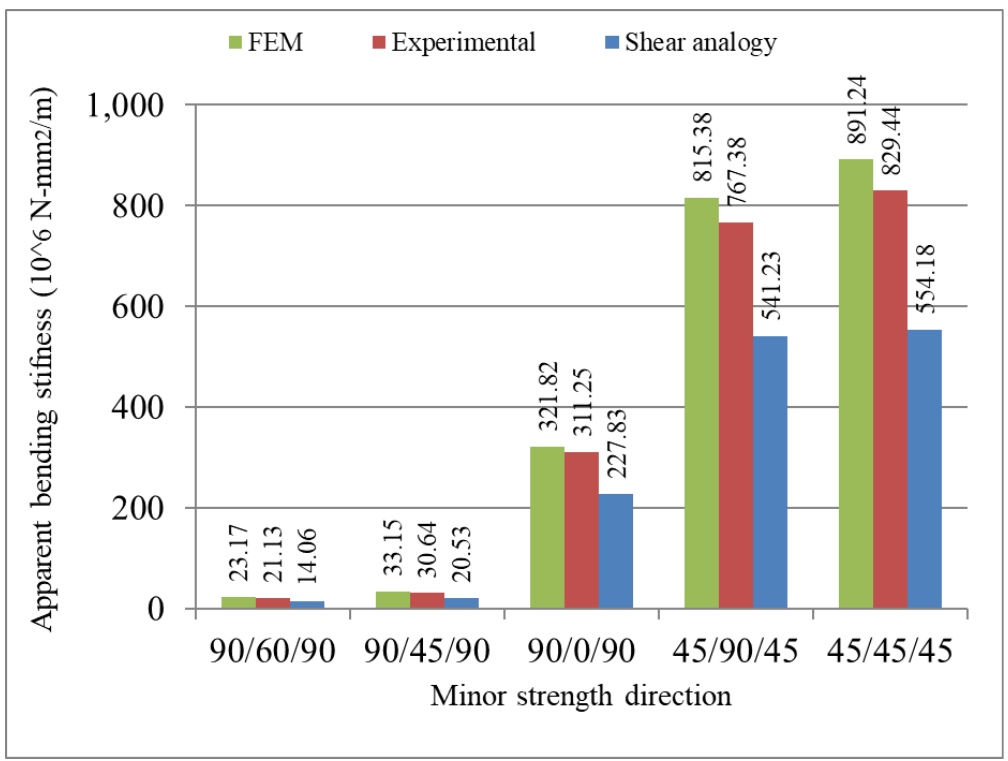
Figure 11. Comparison of apparent bending stiffness (EI app ) values using the experimental test, shear analogy, and FEM approaches in minor axis of CLT.